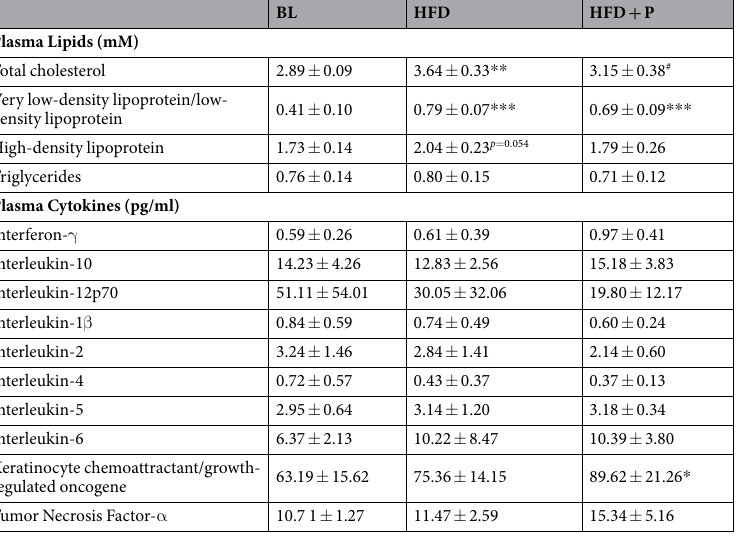
Table 1. Plasma lipid and cytokine concentrations. Data represent the means ± standard deviation of 6 mice per group. Values of p were determined using one-way ANOVA with Tukey’s (equal variance) or Dunnett’s T3 (unequal variance) post-hoc analysis where ∗ p < 0.05, ∗∗ p < 0.01, and ∗∗∗ p < 0.001 versus the BL group; # p < 0.05 versus the HFD group. Values of p compared to the BL group are stated where appropriate.